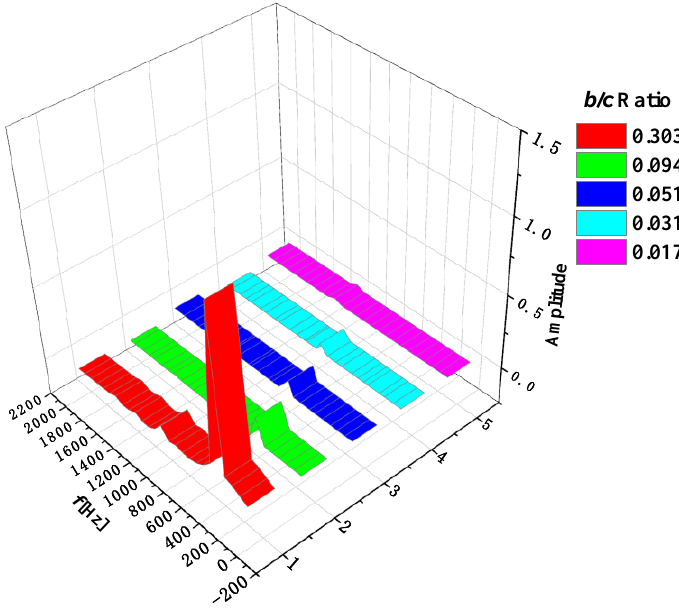
Figure 14. Vortex shedding characteristics of each model in the frequency domain.